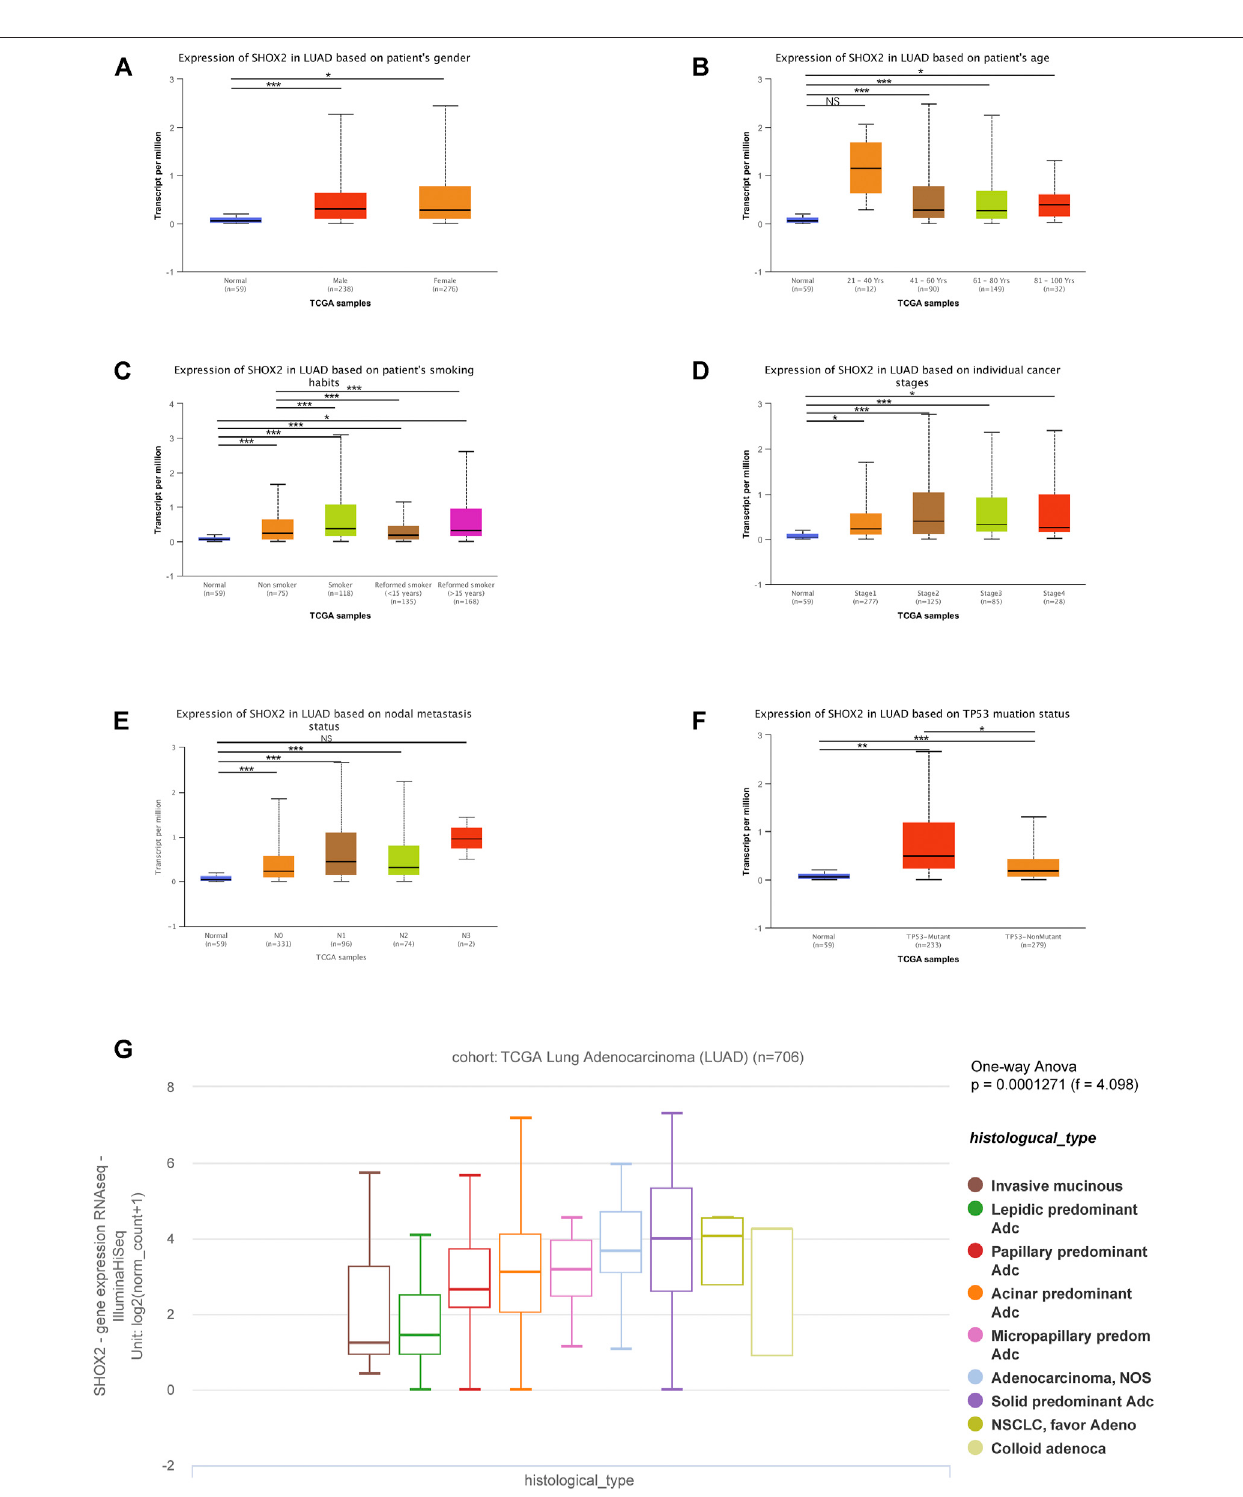
FIGURE3| Boxplotshowingthecharacteristicrelationshipsof (A) gender, (B) age, (C) smokinghabits, (D) stage, (E) nodalmetastasis, (F) TP-53mutationstatus, and (G) histologicalsubtypeswith SHOX2 mRNAexpressioninLUADanalyzedusingtheonlinetoolsUALCANandUCSCXena.Dataarerepresented asmean ± SE.*** represents p < 0.001 (highly signi fi cant); ** represents p < 0.01 (very signi fi cant); * represents p < 0.05 (signi fi cant); LUAD: lung adenocarcinoma.